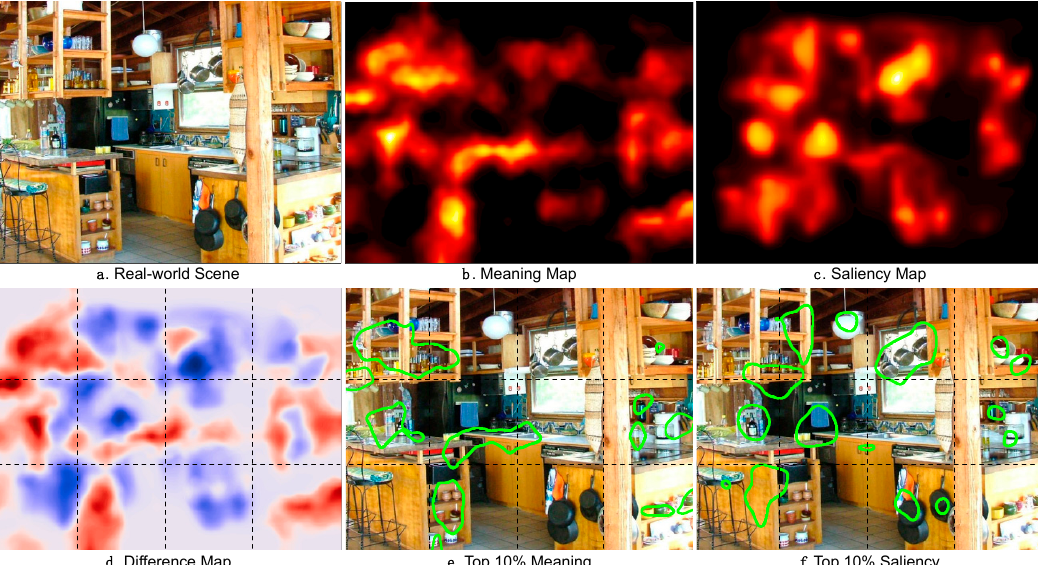
Figure 3. ( a ) Real-world scene; ( b ) scene’s meaning map; ( c ) saliency map; ( d ) difference map showing regions that are more meaningful (red) and salient (blue); ( e ) regions in the top 10% of meaning values; ( f ) regions in the top 10% of saliency values.